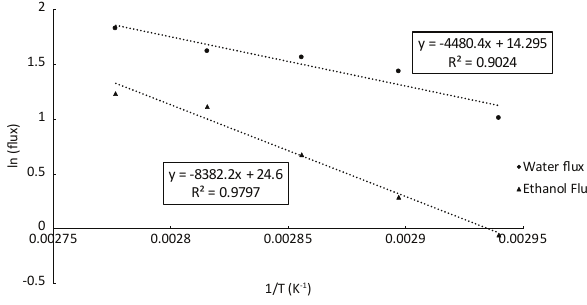
Figure 8: Logarithm of water and ethanol flux against the inverse of